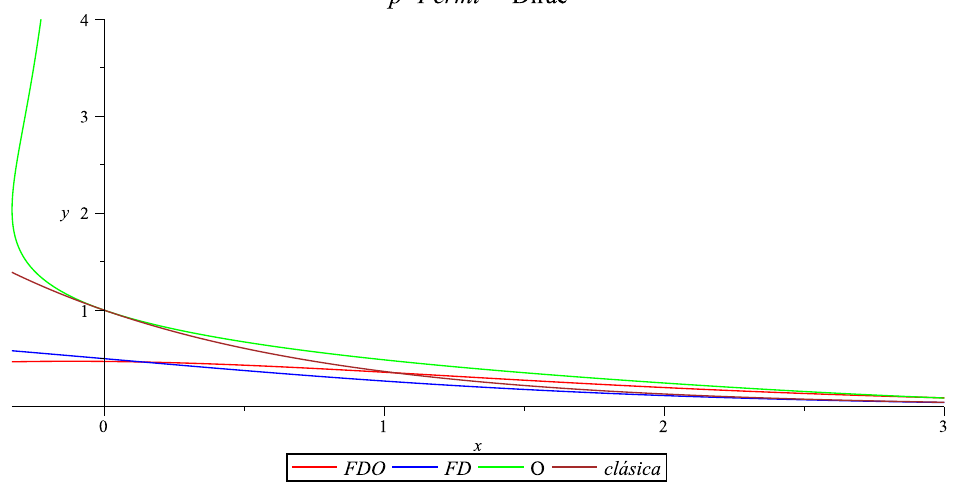
( β E ) . The red line l I